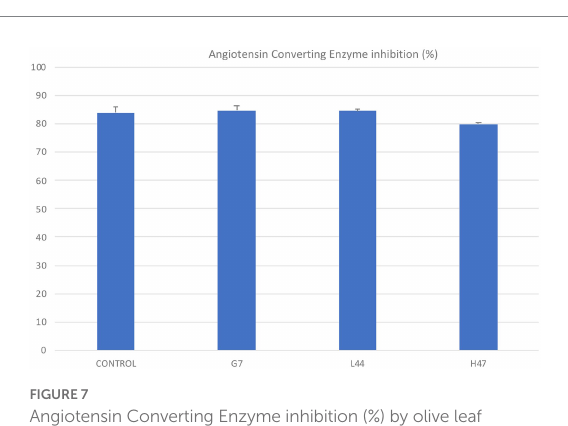
FIGURE 7 Angiotensin Converting Enzyme inhibition (%) by olive leaf extracts obtained from inoculated (G7, L44, and H47) and non- inoculated controls. For each treatment and parameter average value ± SE value is presented ( n = 6). Asterisks indicate significant differences, according to T student test ( p <